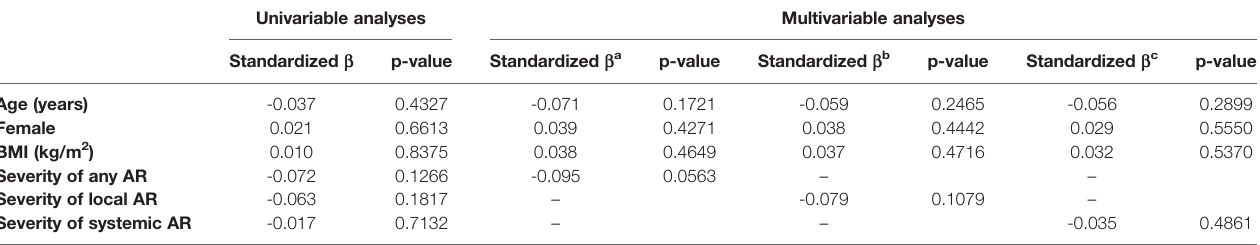
TABLE 2 | Linear regression models for natural log-transformed anti-SARS-CoV2 S-RBD antibody at 4 weeks after the second injection of ChAdOx1 nCoV-19 vaccine. Univariable analyses Multivariable